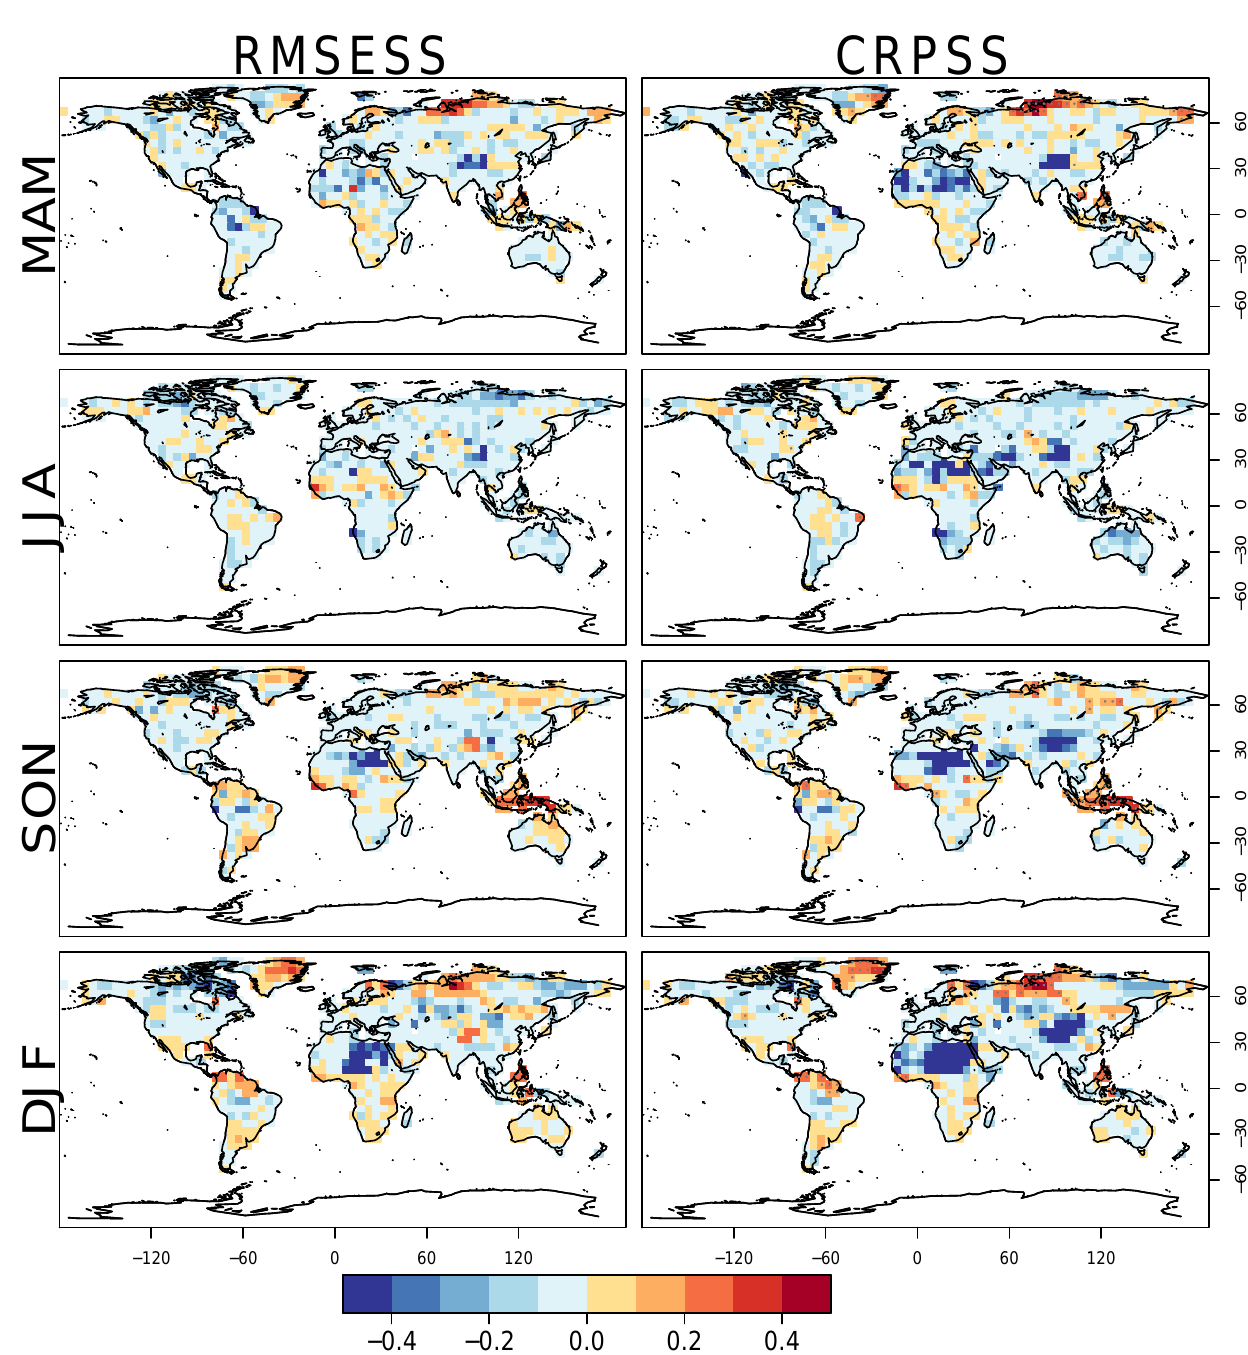
Figure 8. Root-mean-squared error skill score (RMSESS) and the continuous rank probability skill score (CRPSS) of the PREC hindcasts expressed as a skill score against a climatology ensemble forecast (1961–2013). For CRPSS, stippling is used to indicate significance at the 95% level following a one-sided t